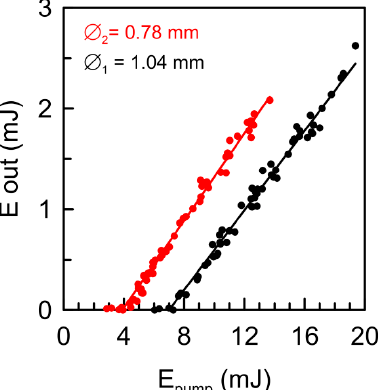
Figure 5. Input/output energy slope lines for Nd:YAG crystal powder pumped at 808.5 nm, for two different diameters of the pump beam: Ø 1 = 1.04 mm ( black points ) and Ø 2 = 0.78 mm ( red points ). Slope efficiency is about 20%, and thresholds are 7.1 and 4.0 mJ respectively.